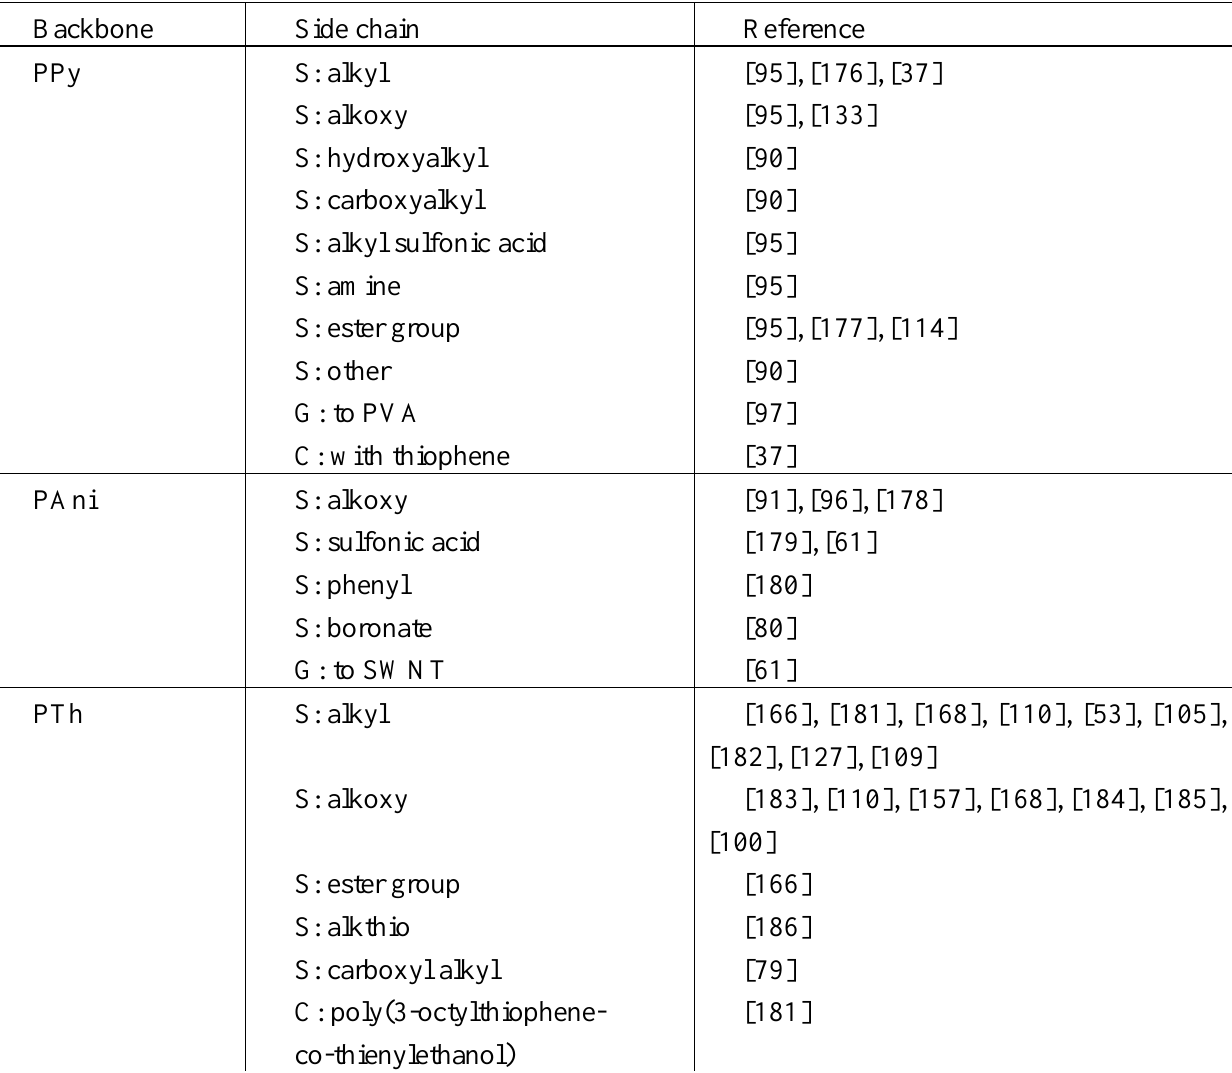
Table 1. Modified conducting polymers for gas